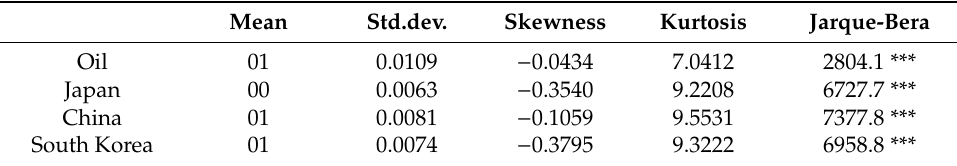
Table 1. Descriptive statistics for crude oil and East Asian stock